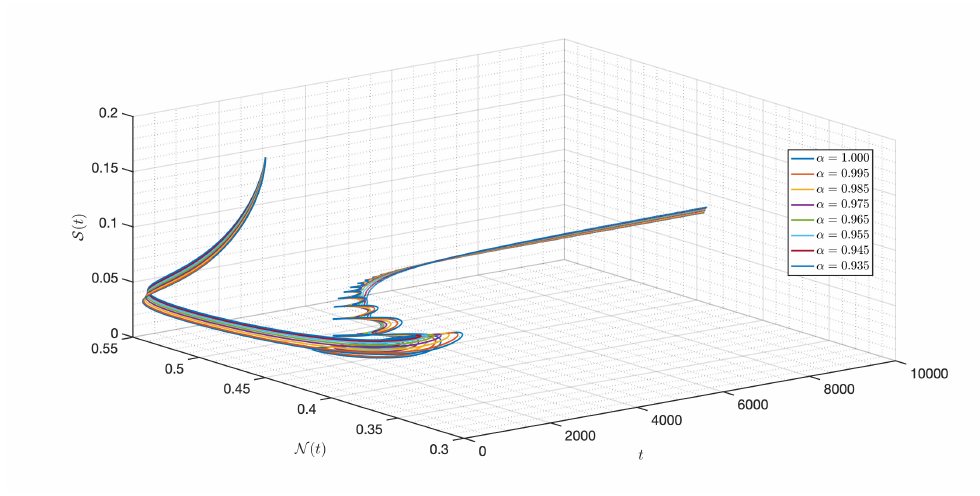
Figure 40. Dynamic of the model (3) for different parameters in Case IV .